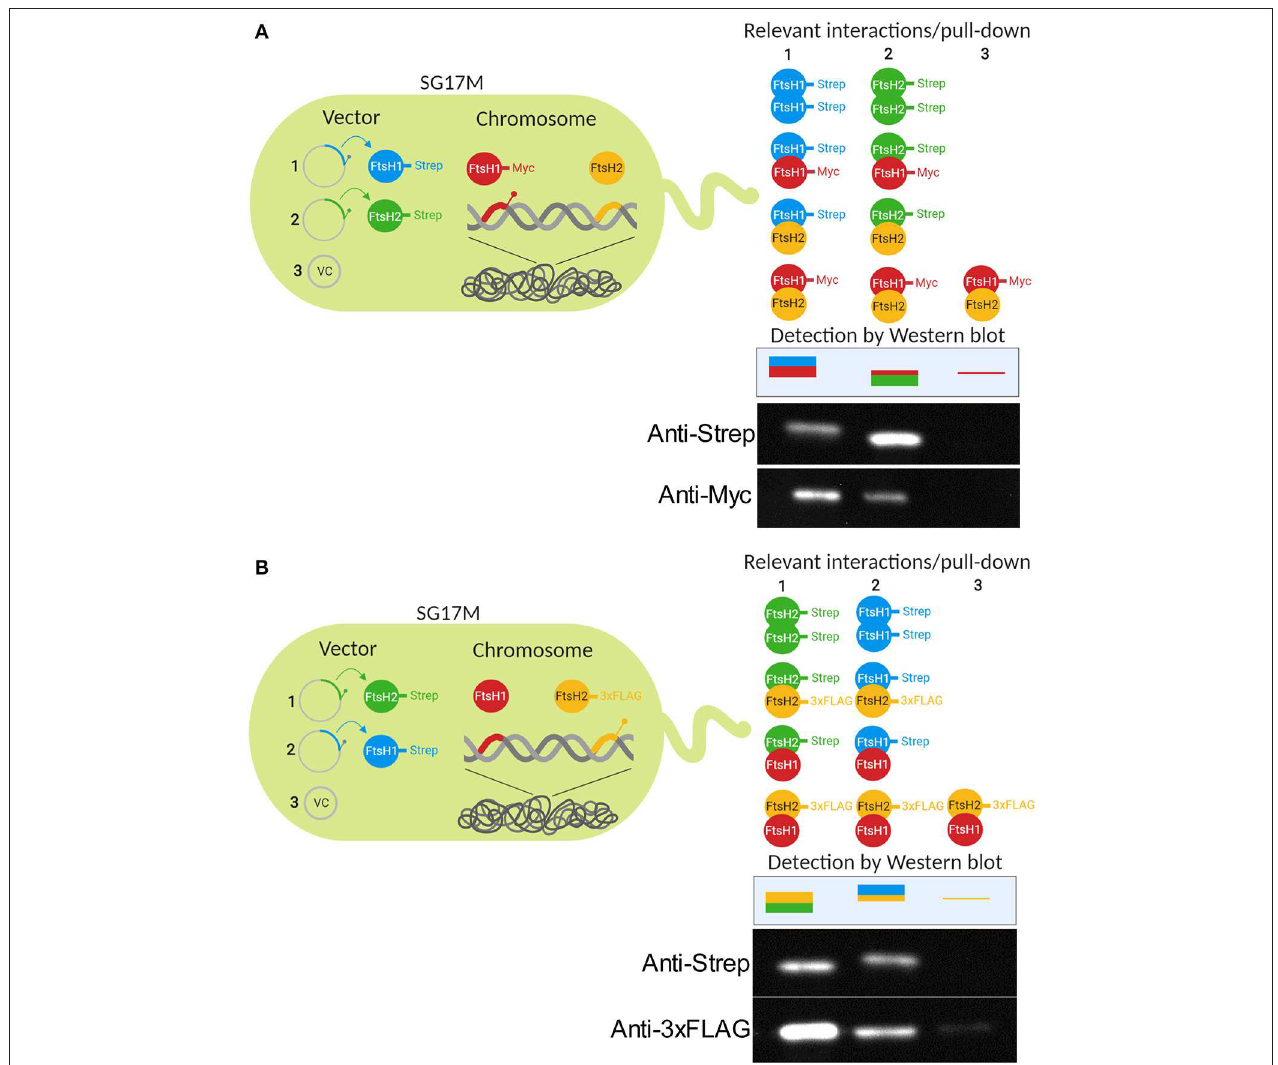
FIGURE 5 | FtsH1 and FtsH2 can form homo- and hetero-oligomers in P. aeruginosa SG17M. Homo- and hetero-oligomer formation of FtsH proteases was tested in pull-down assay using cells in the logarithmic growth phase at 37 ◦ C in SG17M in the FtsH1-Myc background (A) and FtsH2-3xFLAG background (B) . Pull-down was performed with FtsH1-Strep or FtsH2-Strep produced from plasmid pJN105. Negative control for the pull down assay was the empty pJN105 vector. Detection of proteins was performed by Western blot analysis using antibodies against the Strep-, Myc-, and 3xFLAG-tag. The sketch demonstrates the experimental set-up (left) and the relevant potential interactions between FtsH proteins and observed Western blot signals for the two tags (right). Figure created with BioRender.